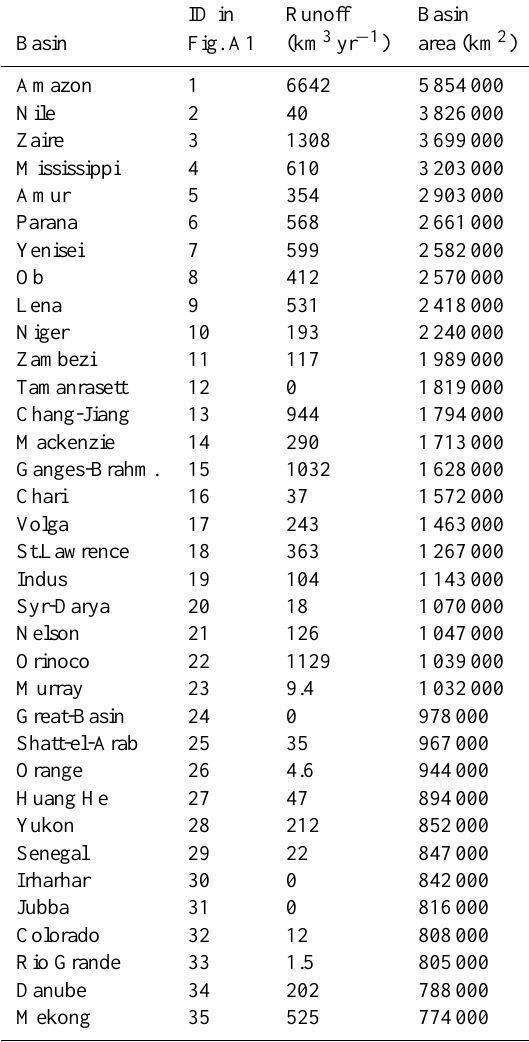
Table A1. River basins used for model evaluation. Data is taken mostly from Vorosmarty et al. (2000) and Dai and Trenberth (2002), with additional data taken from Probst and Tardy (1987), Shahin (1989), Aladin et al. (2005), and Meshcherskaya and Golod (2003). ID in Runoff Basin Basin Fig. A1 (km 3 yr − 1 ) area (km 2